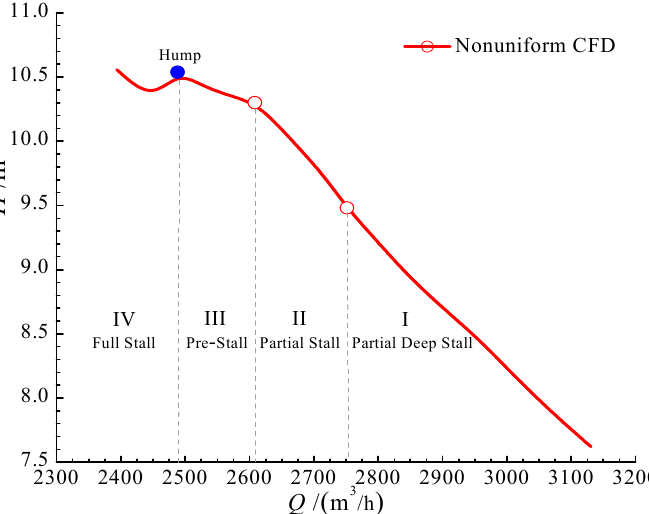
Figure 12. Multi-segment head curve of waterjet pump under nonuniform